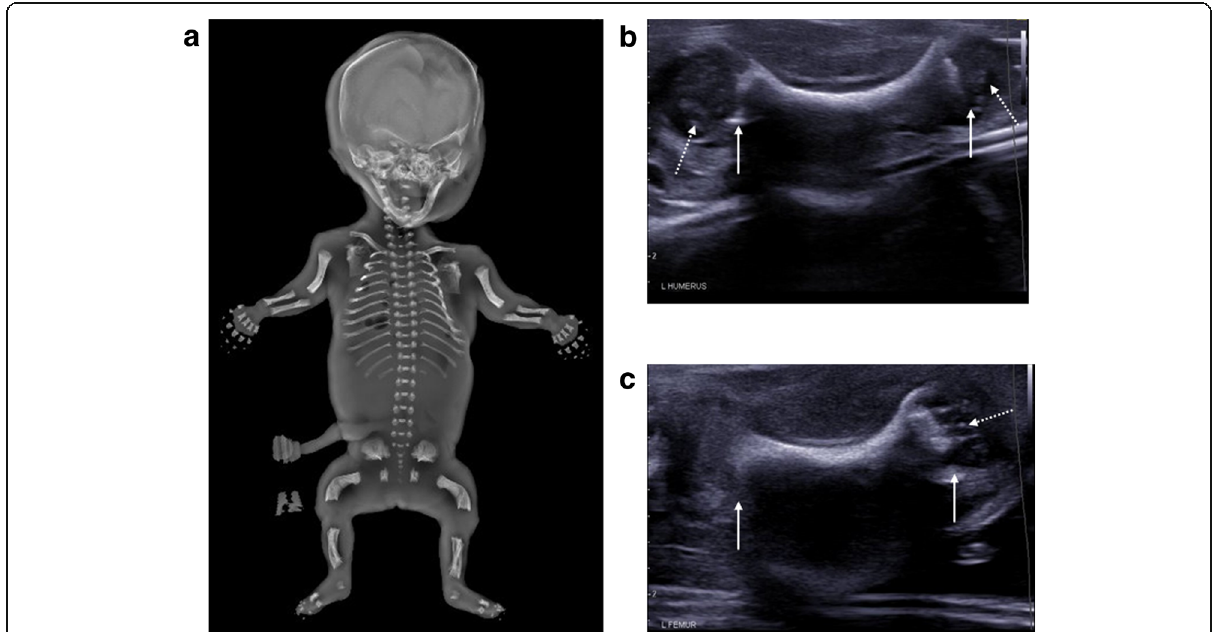
Fig. 23 Thanatophoric dysplasia in a foetus at 22 weeks gestation, following termination of pregnancy. The frontal projection of the skeletal survey ( a ), acquired 2 days after delivery, demonstrates shortened long bones and curved femora with a trident appearance to the acetabulae. Post-mortem ultrasound images in sagittal plane of the left humerus ( b ) and left femur ( c ) reveal irregular metaphyses (solid arrows) and curved long bones. On ultrasound, it is also possible to visualise the unossified epiphyses (dotted arrows)